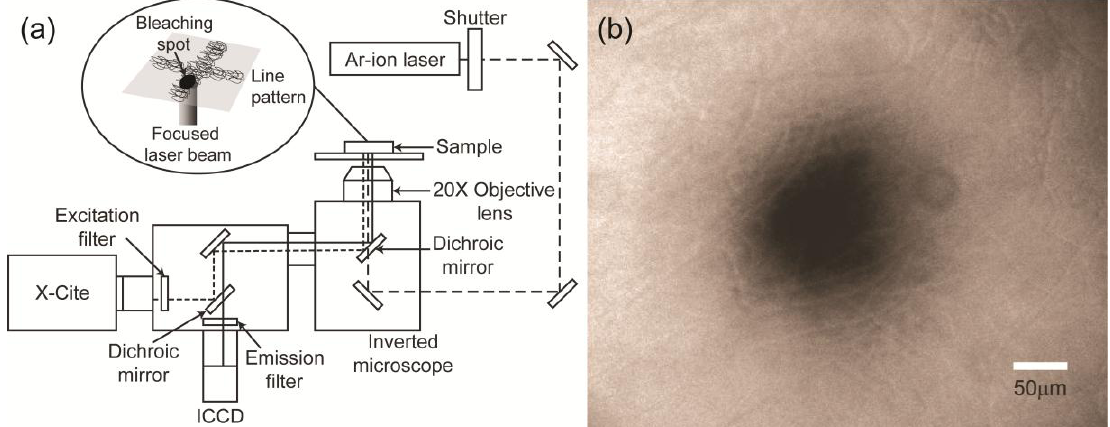
Figure 7. Fluorescence recovery after photobleaching (FRAP) system for diffusion coefficient measurements. ( a ) Experimental setup; ( b ) Image of a bleaching